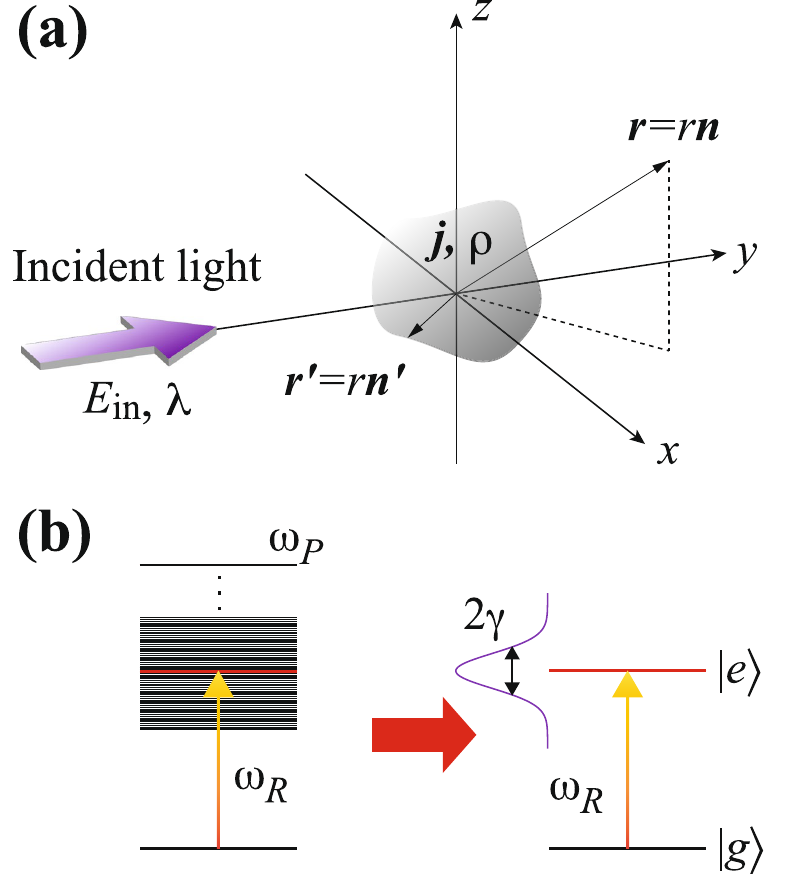
Figure 1. ( a ) Schematic of the analytical model. A nanometal is located at the origin and interacts with incident . ′ r is defined within the nanometal and r is defined outside it ( ≥ ′ r r ). n and n ′ are the unit vectors of r light E n i and r ′ , respectively. ( b ) Effective quantum two-level system of LSP, where ω line indicates the plasmon